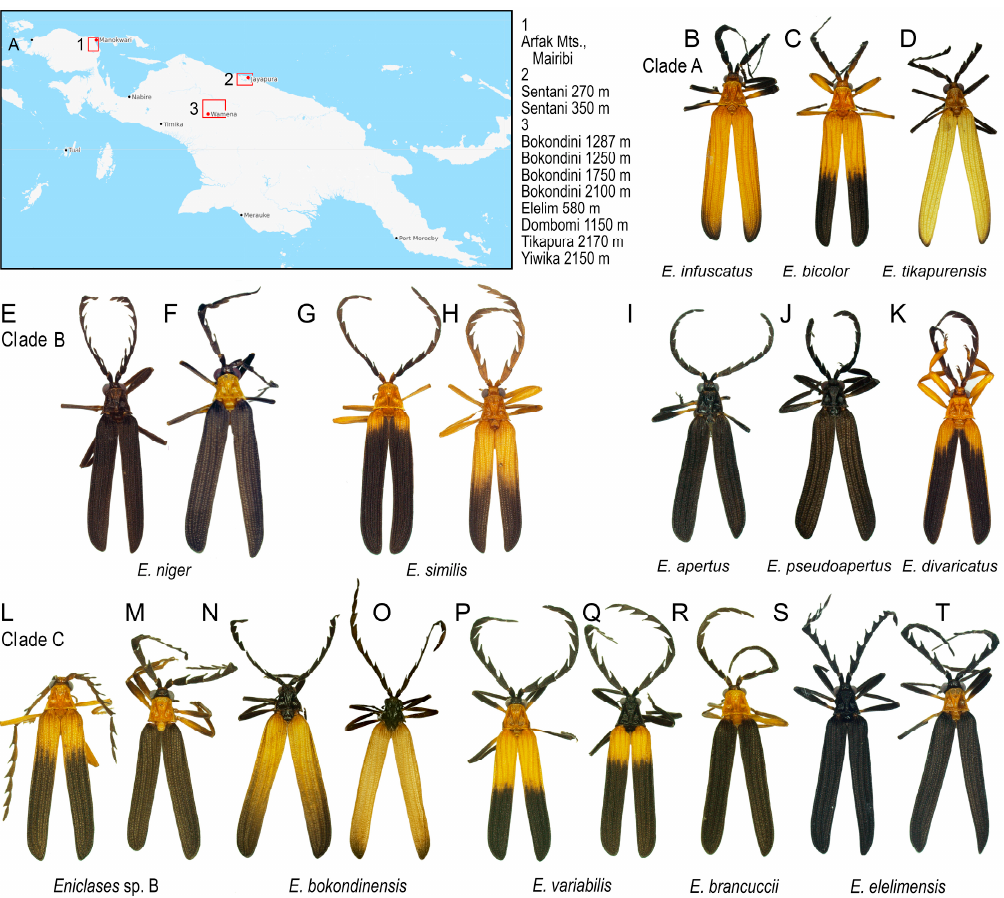
Figure 2. ( A ) Study area; ( B – T ) Eniclases species included in the study (Photographs © Authors).